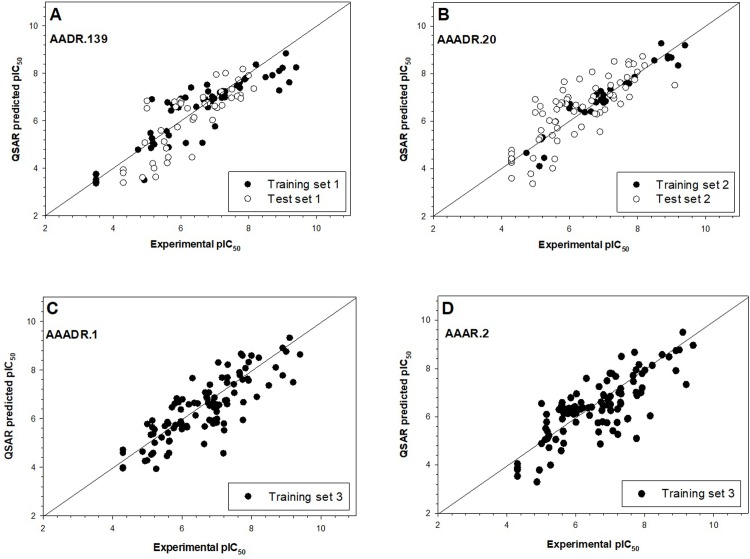
The performance of the 4 models on predicting actives of the test set compounds.A, model AADR.139 generated from training set 1. B, model AAADR.20 generated from training set 2. C, model AAADR.1 generated from training set 3. D, model AAAR.2 generated from training set 3. In the cases of models AAADR.1 and AAAR.2, there were no test set compounds as all 268 compounds were used as training, as described in details in Materials and Methods.